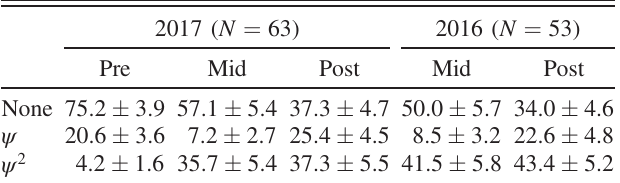
TABLE IV. The percentage of responses in the pre-, mid-, and post-test responses with no graph ( “ None ” ), graphs of the wave function ψ (that sometimes also included a graph of the perturbation V ), and graphs of the probability density ψ 2 (that sometimes also included graphs of ψ and V ). Errors are the standard errors on the